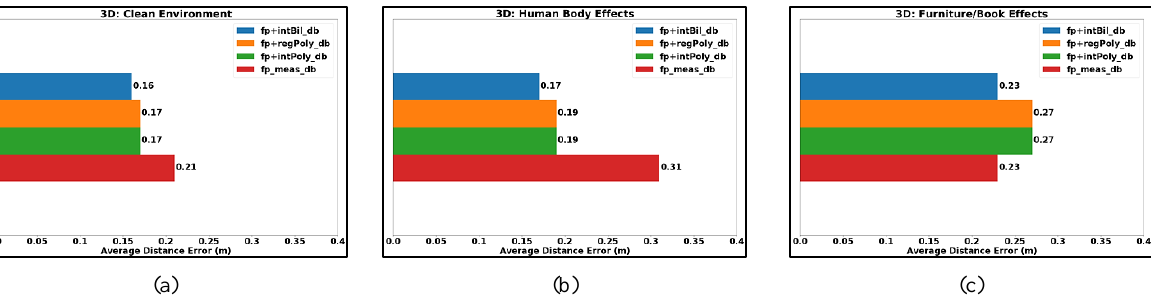
Figure 24. Localization results comparison, a) clean environment, b) human body effects, c) furniture/book